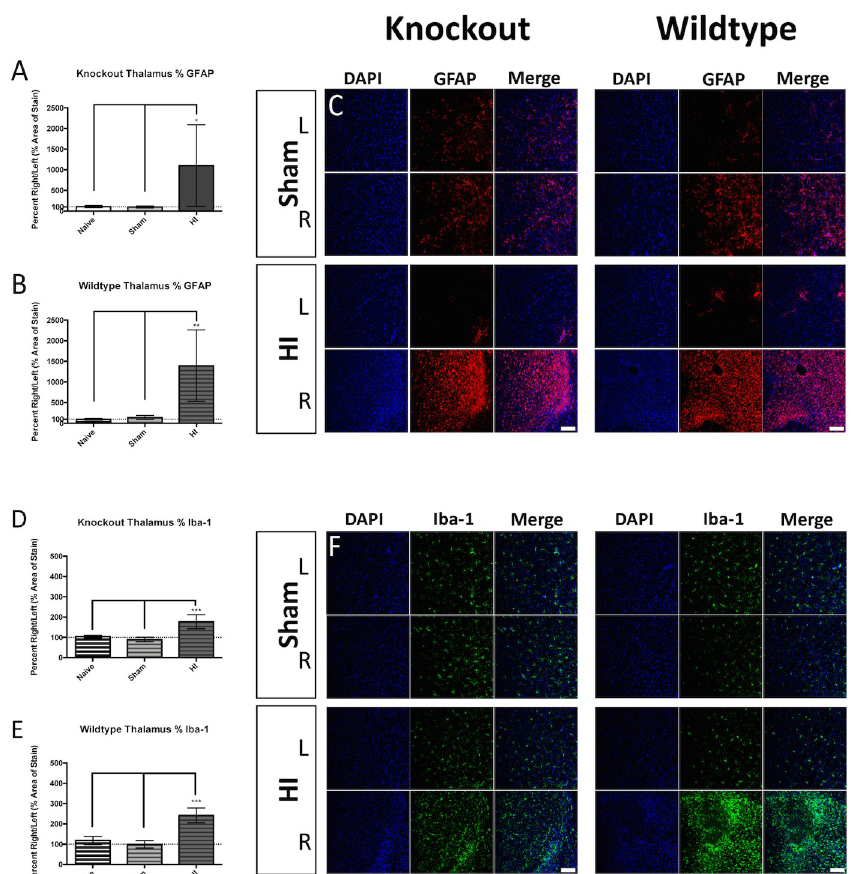
Fig 7. Thalamus gliosis. KO injured (A) and WT injured (B) animals displayed a significant increase in the percent area occupied by GFAP-positive signal when compared to uninjured controls. Representative immunofluorescence is depicted for KO Sham (C top left), KO injured (C bottom left), WT Sham (C top right), and WT injured (C bottom right) in the right and left hemispheres (blue = DAPI, red = GFAP). Percent area occupied by Iba-1-positive staining was elevated in both KO injured (D) and WT injured (E) injured animals when compared to uninjured controls. Representative immunofluorescence is depicted for KO Sham (F top left), KO injured (F bottom left), WT Sham (F top right), and WT injured (F bottom right) in the right and left hemispheres (blue = DAPI, green = Iba-1). Scale bars = 100 μ m, 20x. Error bars = ± SD. � p < 0.05, �� p < 0.01, ��� p <